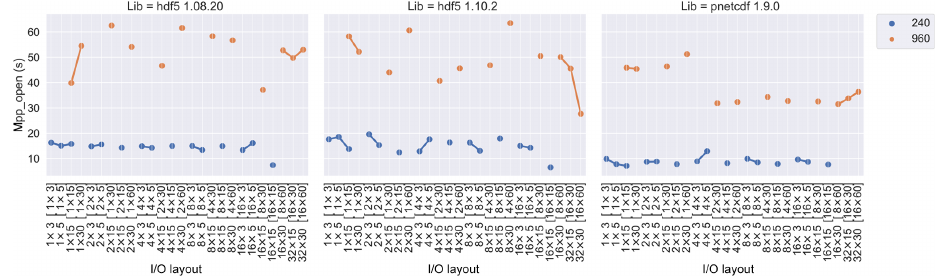
Figure 3. mpp_open time (in seconds) versus I / O layout in different libraries and PE numbers. HDF5 times are generally larger than in PnetCDF, and the runtime increases as PEs increase from 240 to 960. The I / O layout together with its PE distribution in [PE per node × nodes] are labelled on the x axis.